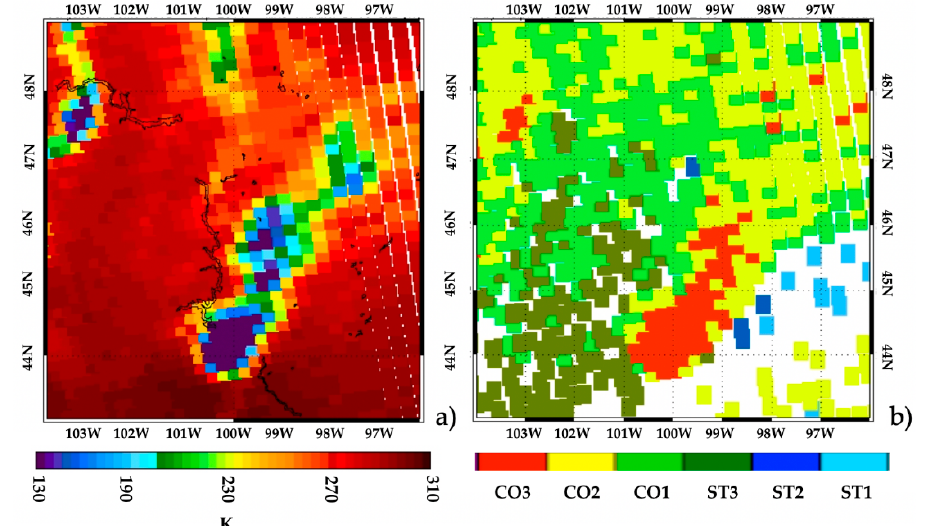
Figure 3. Hailstorm over South Dakota on 23 July 2010 2254 UTC. ( a ) Microwave Humidity Sounder (MHS) channel 2 TBs (K); ( b ) MWCC cloud classification. Colors in b) identify deep (CO3) to shallow (CO1) convection (red to light green) and high (ST3) to low (ST1) stratiform clouds (dark green to cyan).